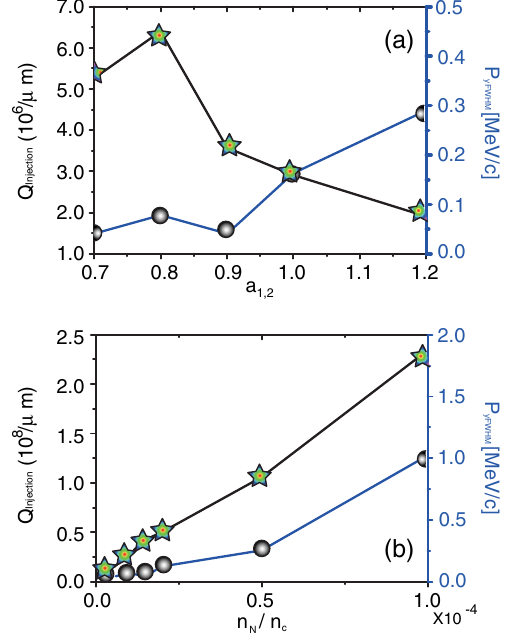
FIG. 3. (a) Electron injection number (stars) and transverse momentum spread (solid circles) versus the transverse laser intensity. (b) Electron injection number (stars) and transverse momentum spread (solid circles) versus the concentration of the neutral